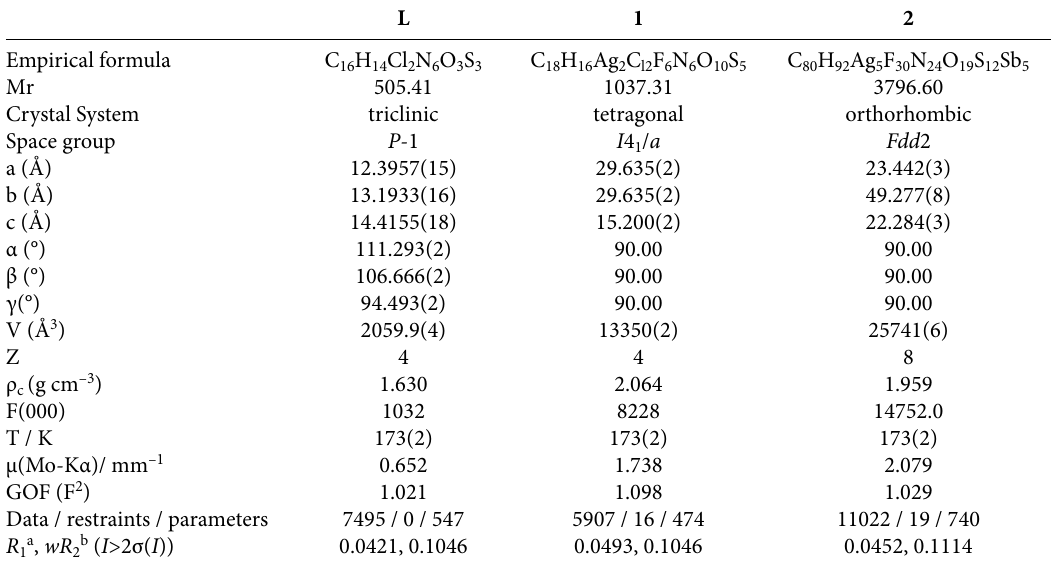
Table 1. Crystallographic data for L , 1 , and 2